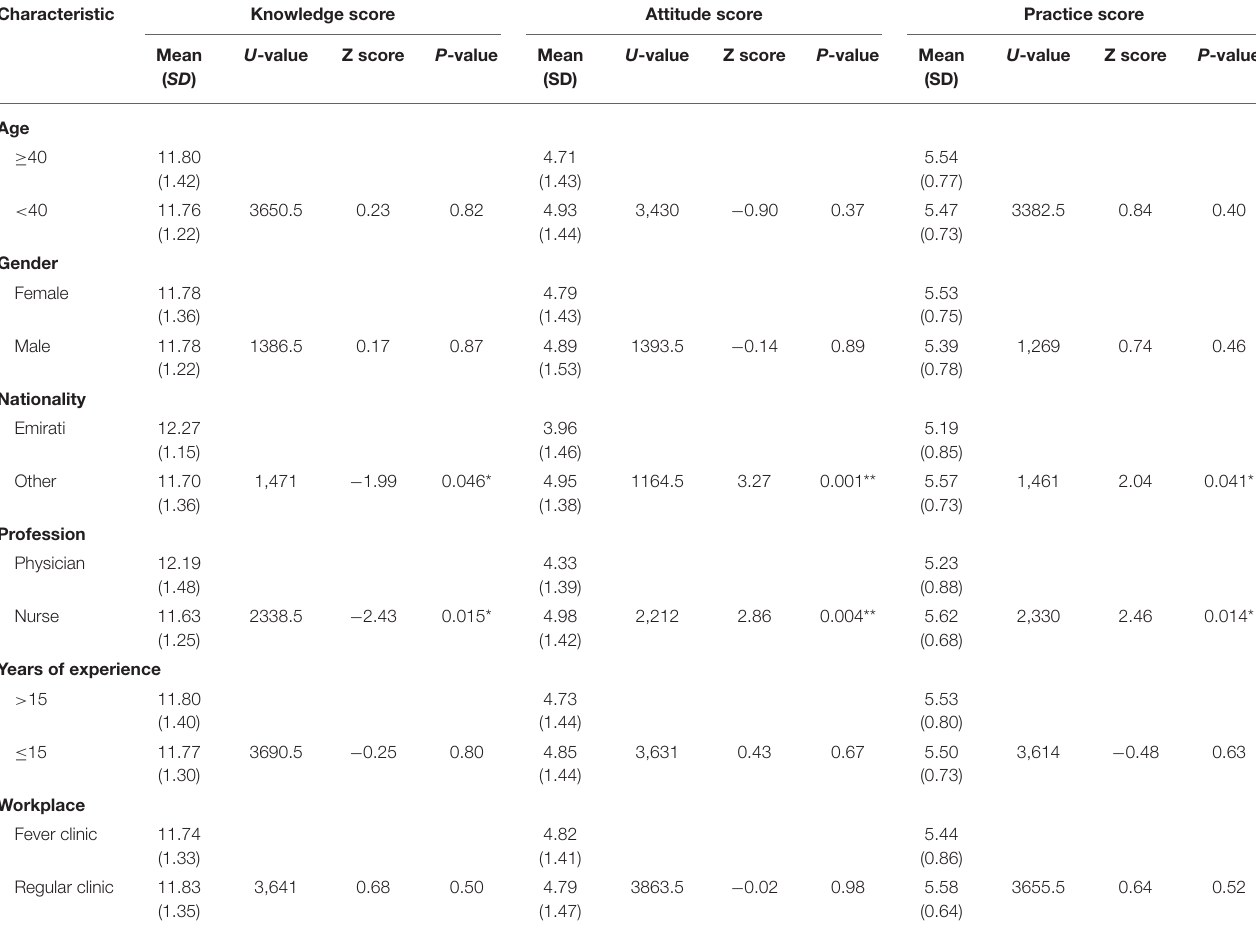
TABLE 4 | Characteristics of participants and their associations with the knowledge, attitude, and practice scores regarding COVID-19 ( n = 176). Characteristic